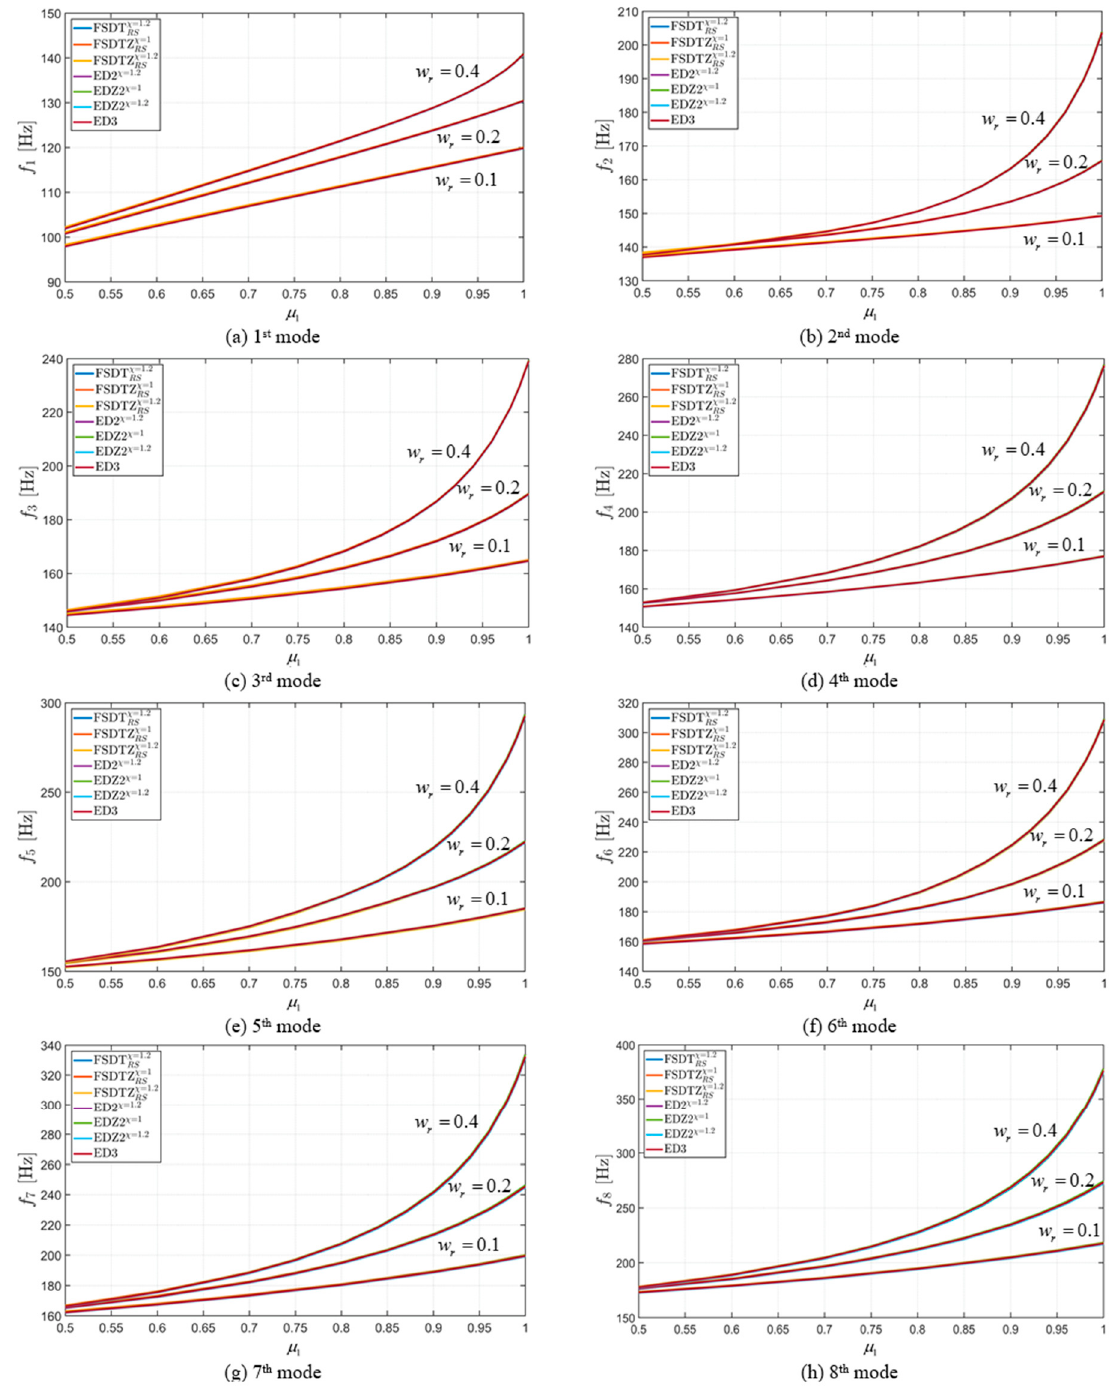
Figure 12. Frequency variations of a CCFF helicoidal surface (Figure 4c) reinforced by CNTs distributed as in Figure 5c for different mass fractions w r when varying the parameter of agglomeration µ 1 with µ 2 = 1. The Chebyshev-Gauss-Lobatto grid distribution was employed, with I N = 31, I M = 21. The following mode shapes are considered: ( a ) 1st mode; ( b ) 2nd mode; ( c ) 3rd mode; ( d ) 4th mode; ( e ) 5th mode; ( f ) 6th mode; ( g ) 7th mode; ( h ) 8th